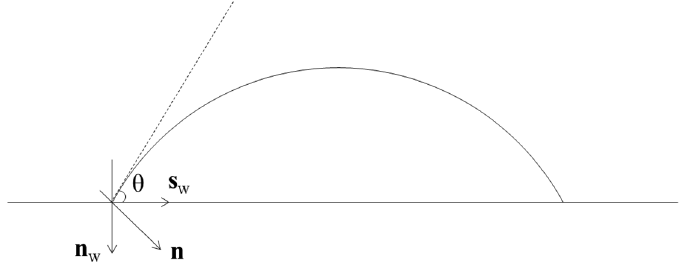
Figure 1. Illustration of the implementation of the contact angle boundary